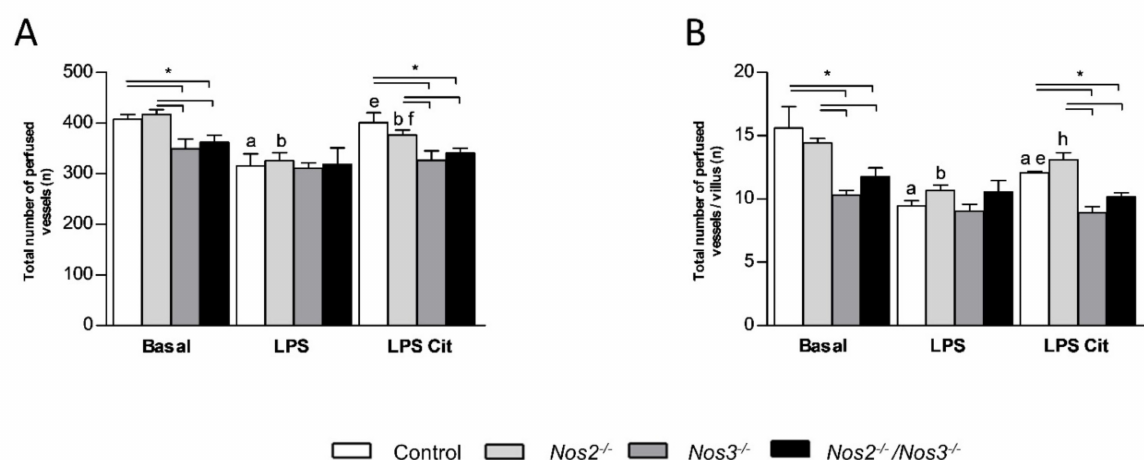
Figure 4. Microcirculatory flow measurements with SDF-imaging in the jejunal villi. ( A ) The total number of perfused vessels in control and Nos -deficient mice under basal and endotoxemic conditions with or without L-citrulline supplementation. ( B ) The number of perfused vessels per villus in control and Nos -deficient mice under basal and endotoxemic conditions with or without L-citrulline supplementation. * p -value < 0.05; a p -value < 0.05 vs. control mice during basal conditions; b p -value < 0.05 vs. Nos2 − / − mice during basal conditions; e p -value < 0.05 vs. control + LPS; f p -value < 0.05 vs. Nos2 − / − mice + LPS; h p -value < 0.05 vs. Nos2 − / − /Nos3 − / − mice + LPS. Data are shown as mean ± SEM. Statistical significance was determined with one-way ANOVA and post-hoc Bonferroni correction between